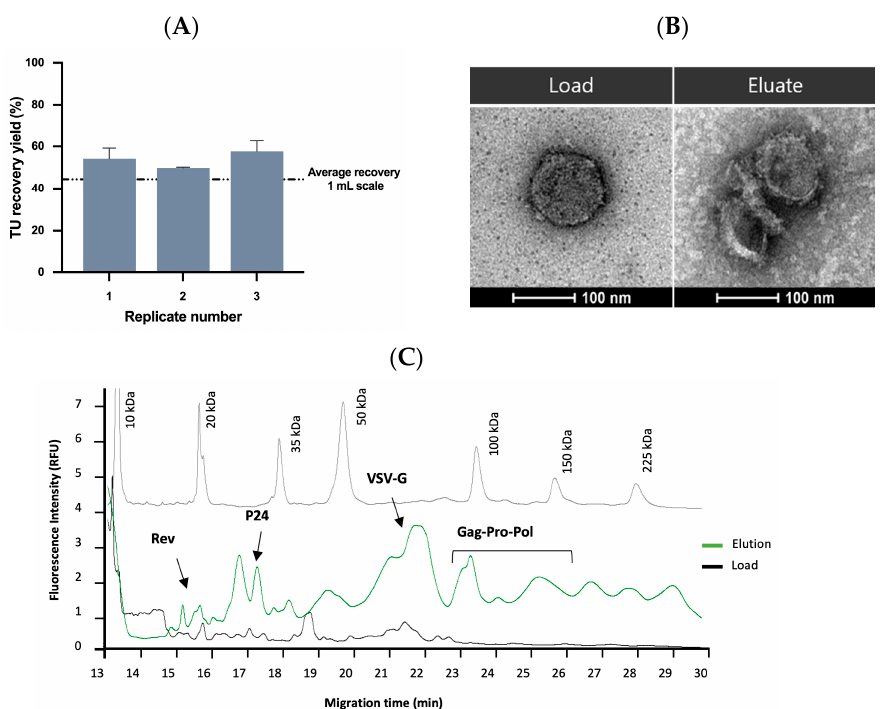
Figure 6. Intermediate scale-up and characterization of purified VSVG-LVs. ( A ) VSVG-LVs purifica- tion at 10 mL scale. The graphic represents the TU yield (%) for each replicate ( n = 3). Dashed line shows the average recovery yield obtained from 1 mL scale (45 ± 10%). Error bars are the standard deviation obtained from the titration method. ( B ) TEM analysis of VSVG-LVs initial sample (left image) and after purification with the Lenti VSVG Affinity Matrix (right image). Scale bar 100 nm. ( C ) Electropherograms represent the molecular weight marker (gray line), the clarified VSVG-LVs sample (black line), and VSVG-LVs purified with the Lenti VSVG Affinity Matrix (green line) using CE-SDS with a LIF detector. Major VSVG-LVs proteins are